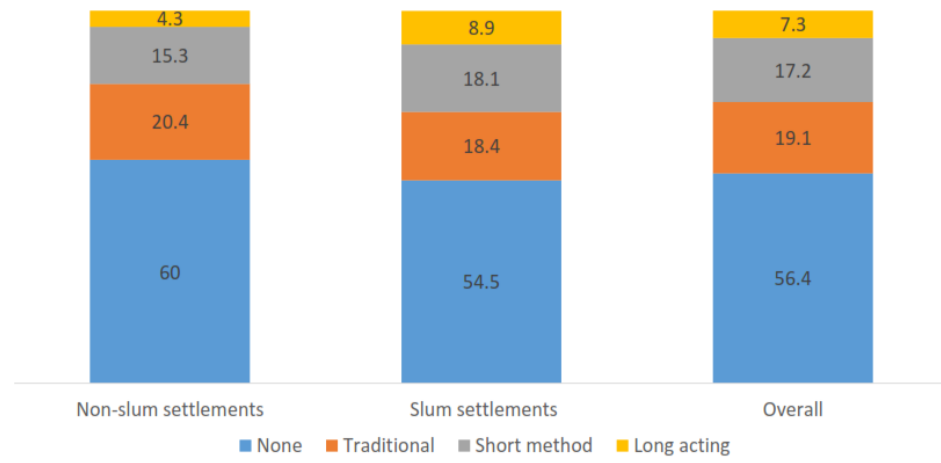
Figure 4. Bivariate association between neighborhoods and contraceptive-method choice. Table 3. Contraceptive method mixes by residence, Kinshasa, 2020.